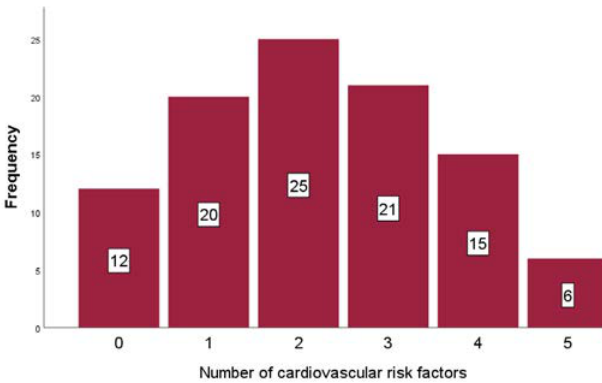
Fig 1 : Distribution of number of cardiovascular risk factors among participants